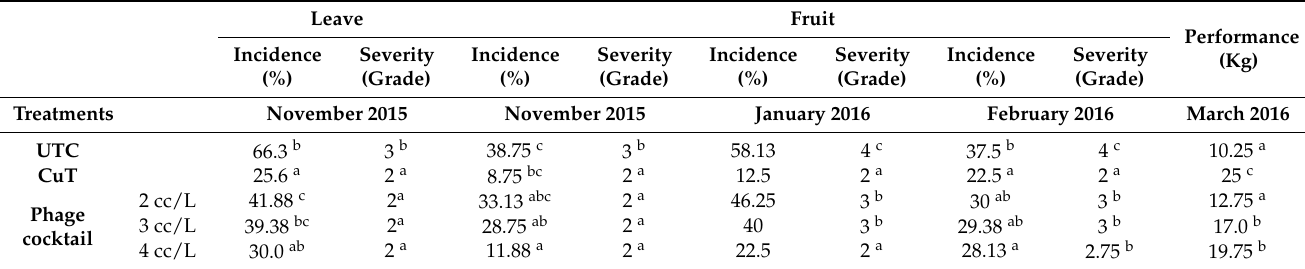
Table 3. Evaluation of incidence and severity in fruit and leaves of walnut trees treated with bacteriophages mix.